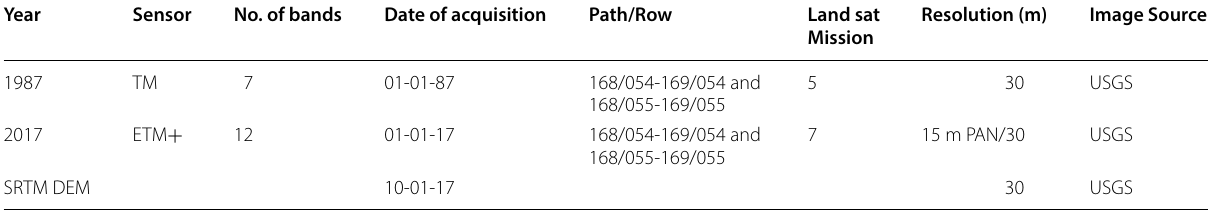
Table 1 Satellite image data collected from different sources